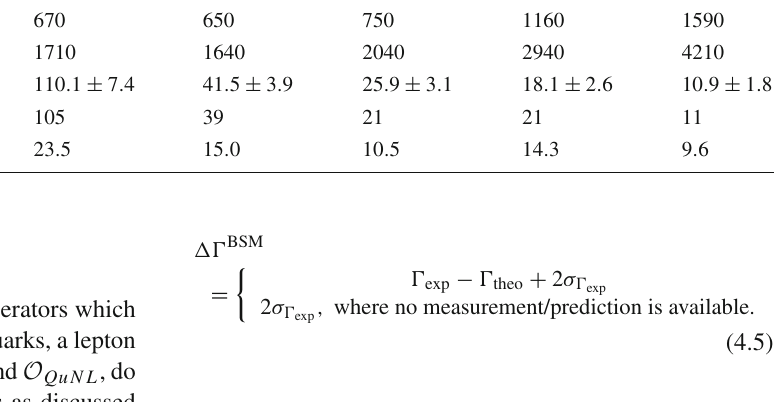
Table 4 CMS diphoton plus missing energy: Number of expected events and data in different bins of the E miss T distribution in Tab. 3 (post-fit) of Ref. [45]. We neglect the overflow